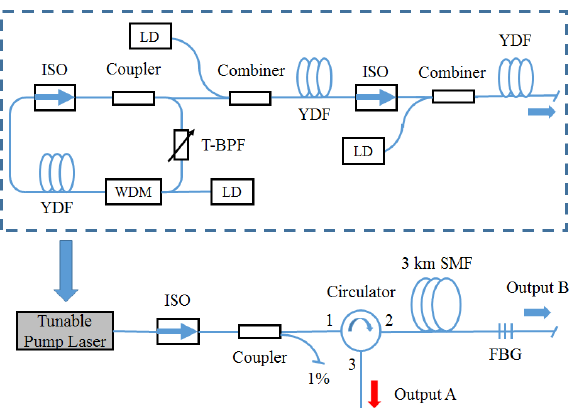
Fig. 1 Schematic of the narrow linewidth random fiber laser (ISO: isolator; YDF: Ytterbium-doped fiber; WDM: wavelength division multiplexing; T-BPF: tunable bandpass filter; LD: laser diode; SMF: single mode fiber; FBG: fiber Bragg